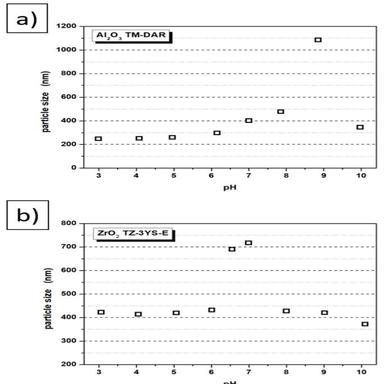
Diagrams of the particle size relationships in the pH function: a) Al2O3, b) ZrO2.